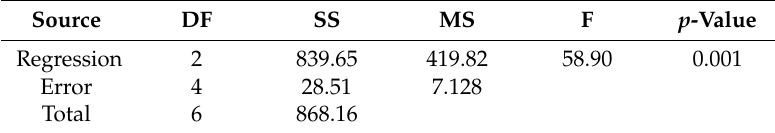
Table 1. Analysis of variance (ANOVA) of the model in Equation (1).